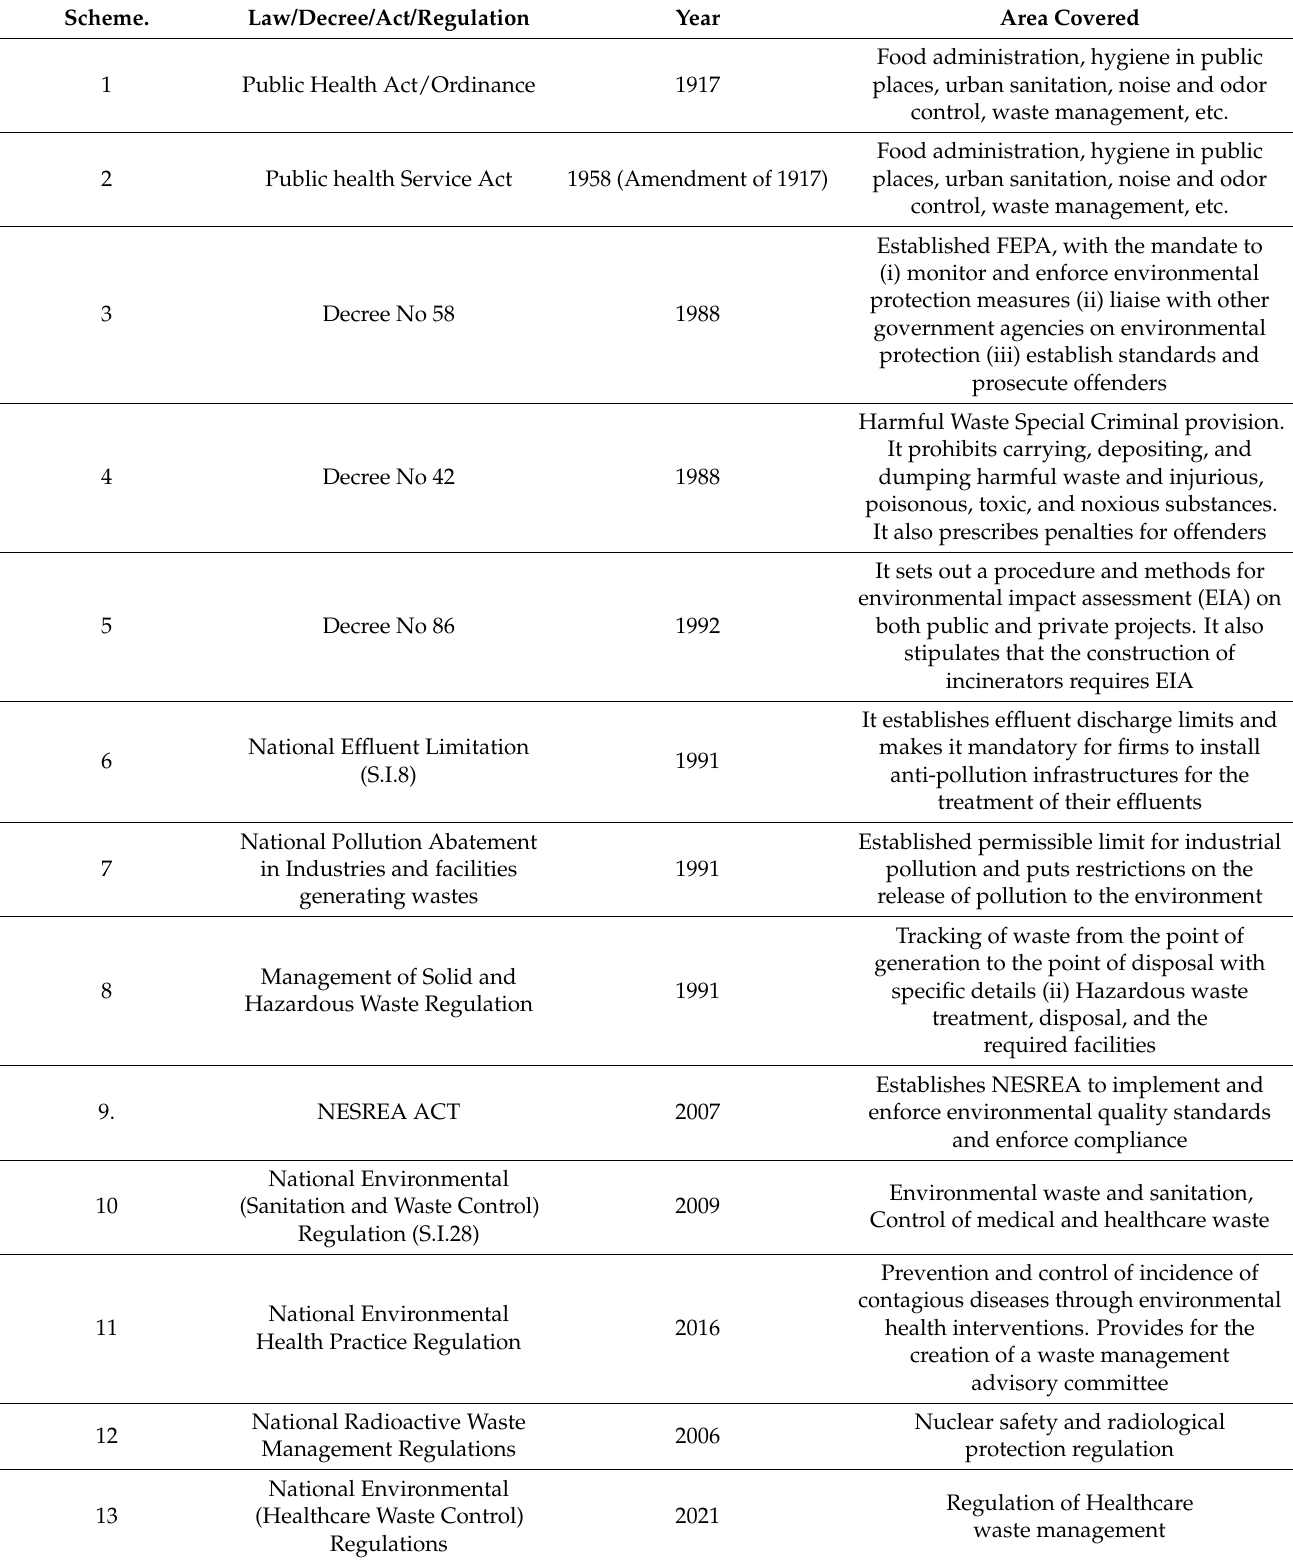
Table 3. Some Environmental Health Laws and Regulations in Nigeria.